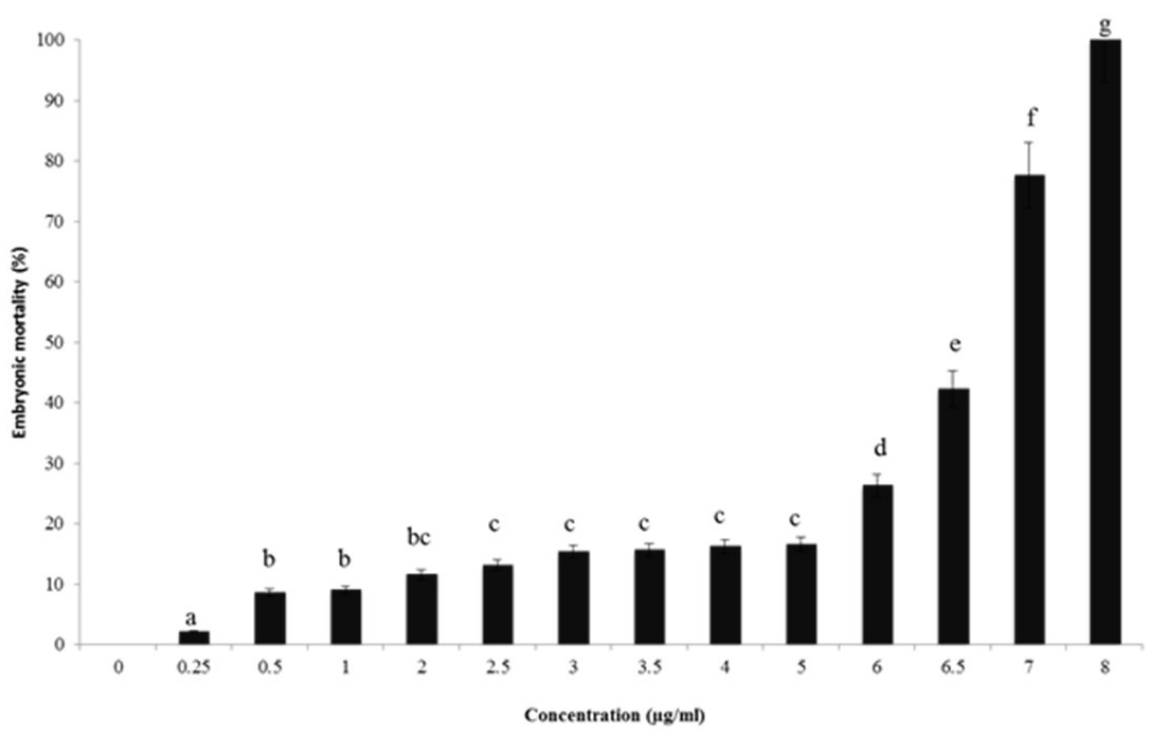
Figure 1. The embryotoxicity of different concentrations of (CSEO) in embryonic zebrafish mortality. All tests were performed in triplicate; Values with a different letter (a–g) are significantly different ( p < 0.05).